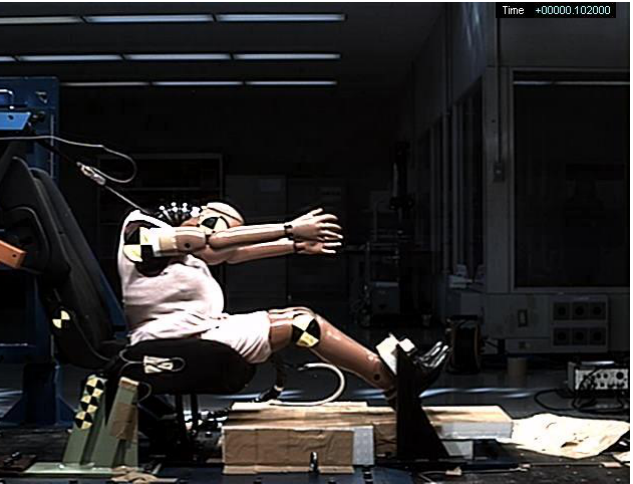
Figure 5. Representative image of the dummy 102 ms after impact, showing the point of peak head excursion (test A).